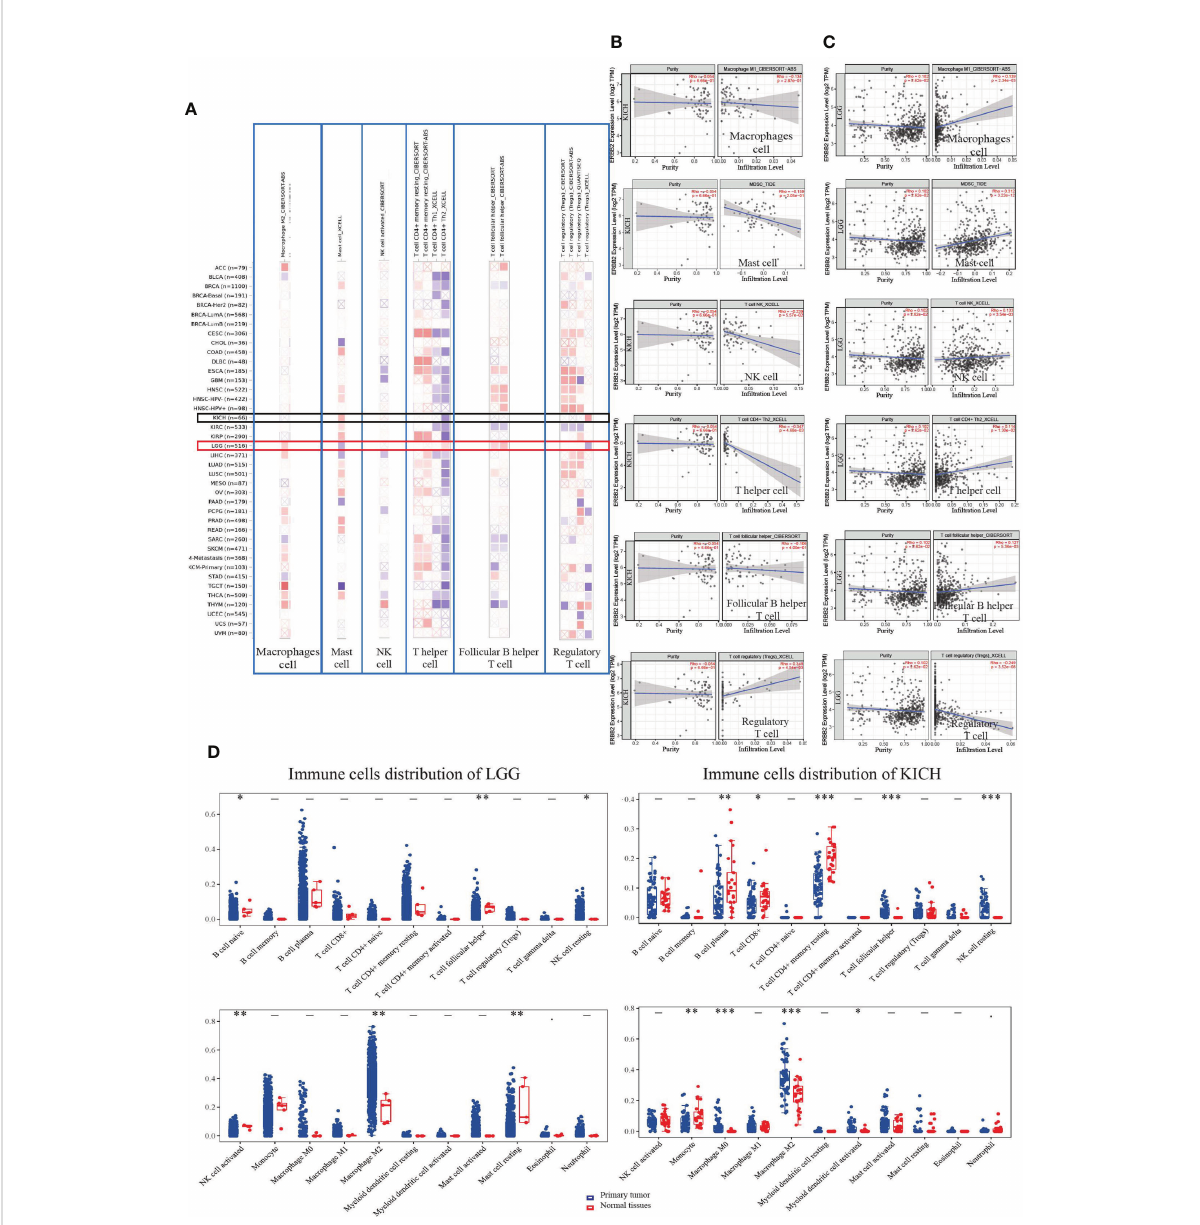
FIGURE 5 The landscape of immune cell in fi ltration on differentially expressed ERBB2 in two types of cancers. (A) A heat map visualizes immune cell in fi ltration for assessing different tumors with mutation status of ERBB2 gene, including mast cells, follicular B helper T cells, T follicular helper, T cell regulatory, macrophage cell, and NK cell. (B) A scatter plot displays the difference of immune cell in fi ltration in KICH, such as Tregs, macrophages, NK, mast cells, Th2, and T helper cells. (C) A scatter plot displays LGG immune cell in fi ltration using TIMER-estimate (D) The 65 samples of KICH and 513 samples of LGG showed immune cell changes compared to their normal tissues. The abscissa represents immune cell types, and the ordinate represents the expression distribution of immune scores in the two cancer groups. *p<0.05, **p<0.01,***p<0.001, asterisks (*) stand for signi fi cance levels. The difference between the two groups presents through the Wilcox